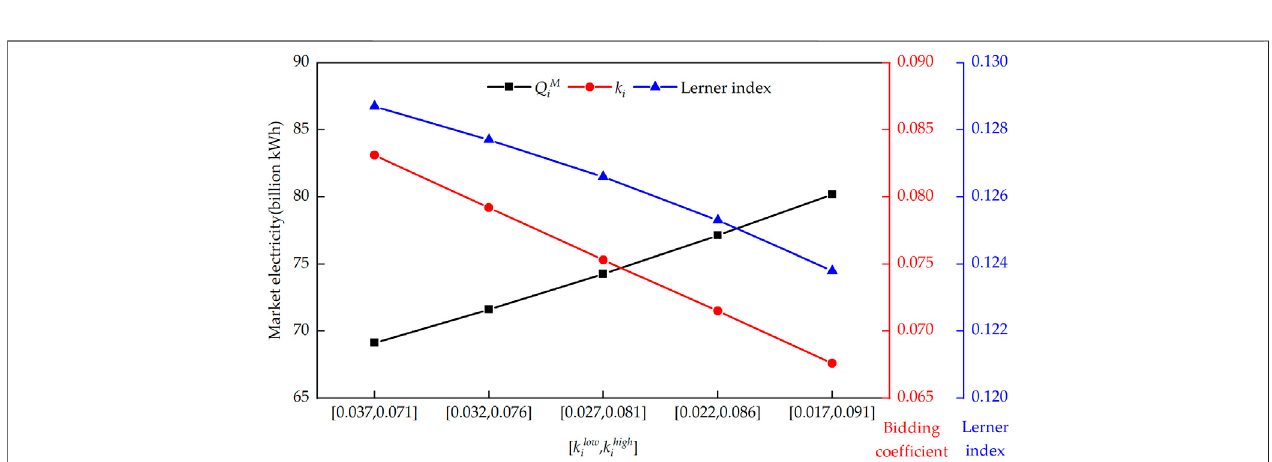
FIGURE 6 | The relationship between optimization results and uncertainty of load demand.